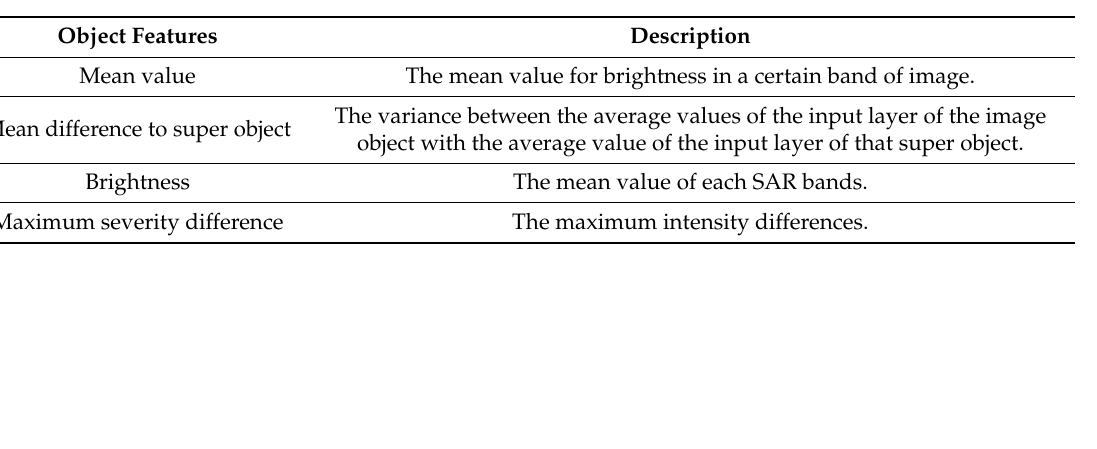
Table 4. Object features used for